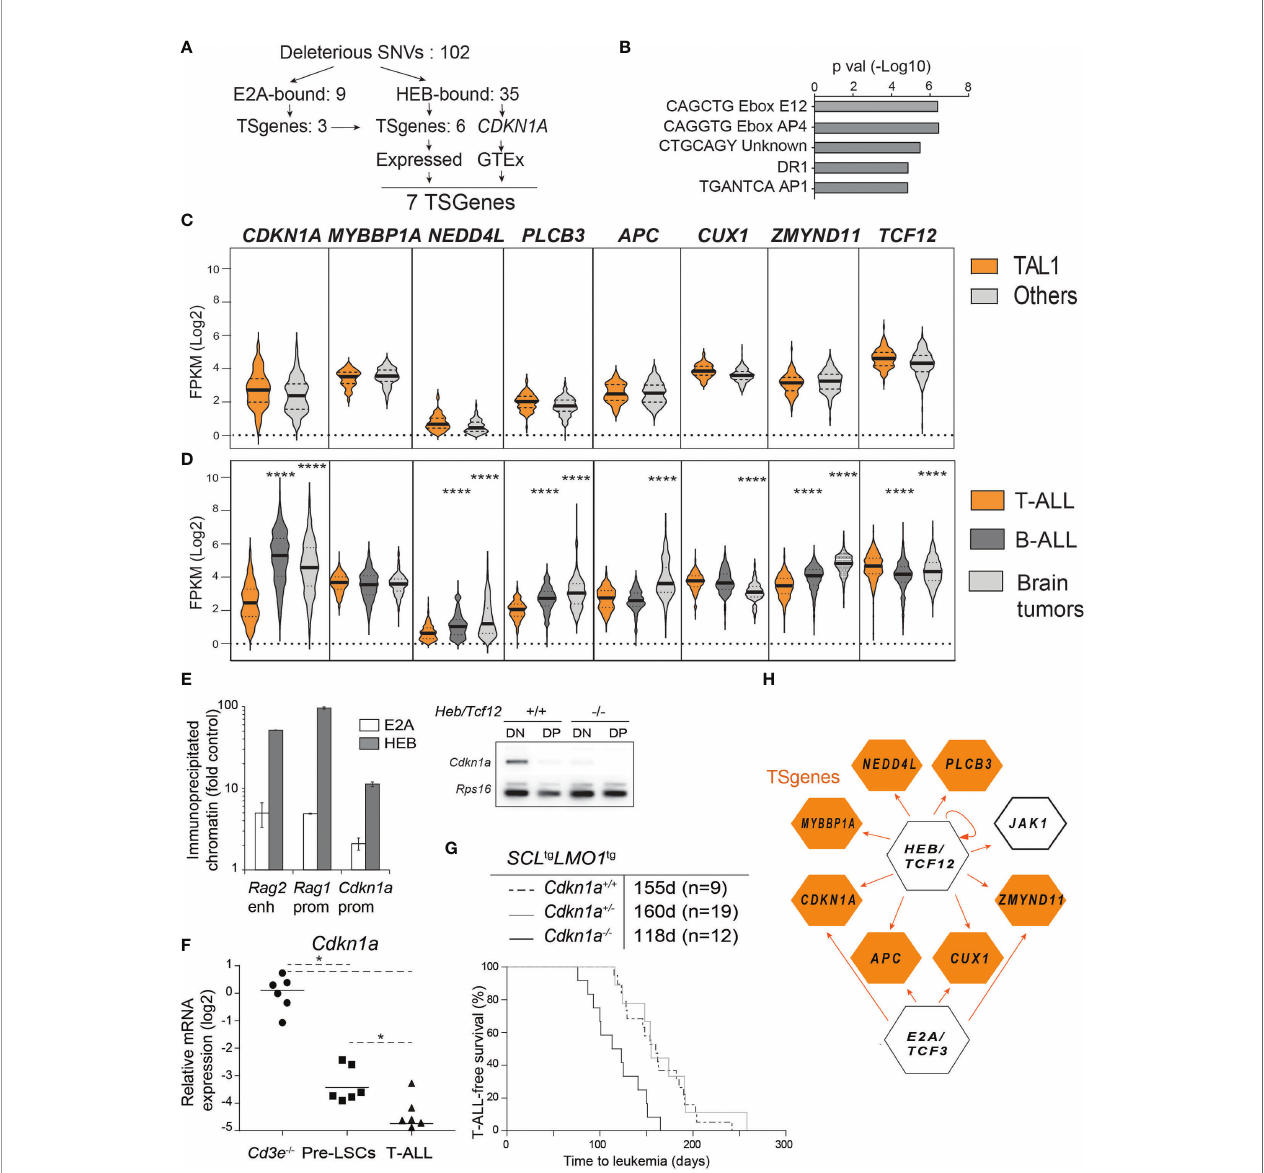
FIGURE 6 | HEB controls a tumor suppressor network in T-ALL. (A) Strategy of tumor suppressor identi fi cation amongst HEB target genes that are mutated in Cd3e - /- SCL tg LMO1 tg leukemic cells. (B) Enrichment in E boxes within the proximal promoter regions of HEB target genes. (C, D) Expression levels of the indicated TSGenes in TAL1+ vs other molecular subgroups in pediatric T-ALL dataset from Liu et al. (C) and in T-ALL, B-ALL and brain tumors from the Pediatric Cancer Genome Project cohort (D) . (E) Chromatin immunoprecipitation of Cdkn1a promoter with HEB and E2A in DN thymocytes. The Rag1 promoter and Rag2 enhancer are included as positive controls (left panel) and RT-PCR analysis of Cdkn1a expression in DN and DP thymocytes in wt and Heb/Tcf12 knockout mice. Ampli fi ed bands were revealed by hybridization with an internal 32 P-labeled oligonucleotide fragment (right panel). (F) Quantitative RT-PCR analysis of Cdkn1a expression in Cd3e -/- DN3 cells, pre-LSCs and leukemic cells. (G) Kaplan-Meyer survival curves of SCL tg LMO1 tg T-ALL with partial and complete loss of Cdkn1a . (H) A tumor suppressor network downstream of HEB or E2A validated by chromatin immunoprecipitation. HEB is autoregulatory but not E2A. *p value < 0.01; ****p value <